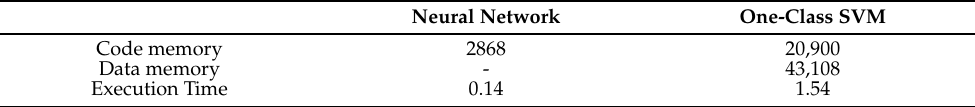
Table 7. Computational cost and execution time. Memory given in bytes, time in